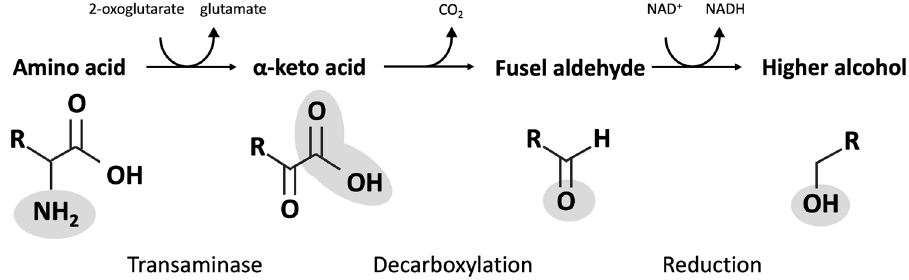
Figure 3. Ehrlich pathway conversion of amino acids into fusel alcohols. Table 2. Amino acids intermediates and products of the Ehrlich pathway. Reconstructed from Hazelwood et al., (2008)